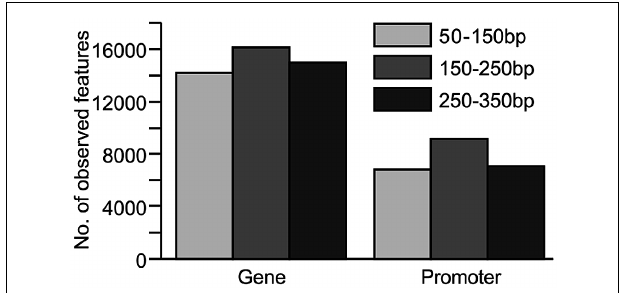
FIGURE 3 | Comparison of coverage at genomic features (genes and promoter regions) from sequence data generated from libraries constructed from various fragment sizes (50–150, 150–250, and 250–350 bp). For inclusion, the genomic feature had to contain at least three CpG sites with ≥ 10x coverage. Promoter regions were defined as 2 kb upstream of the transcription start